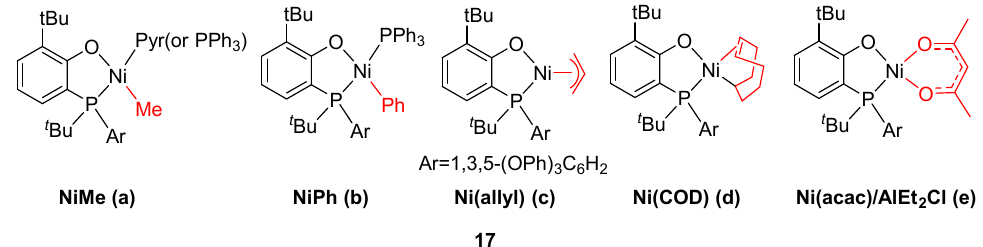
Figure 14. Phosphine-phenolate nickel catalysts 17a – e with versatile initiating groups.